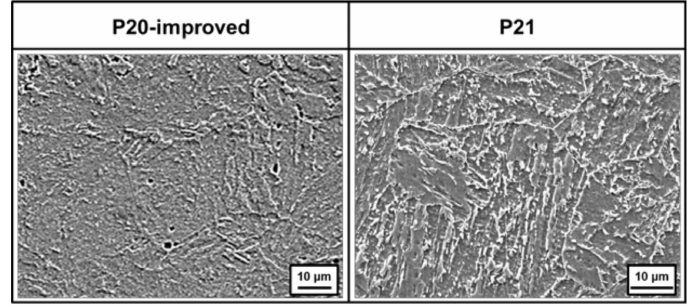
Figure 2. SEM micrographs of P20-improved and P21 steels (as-received).